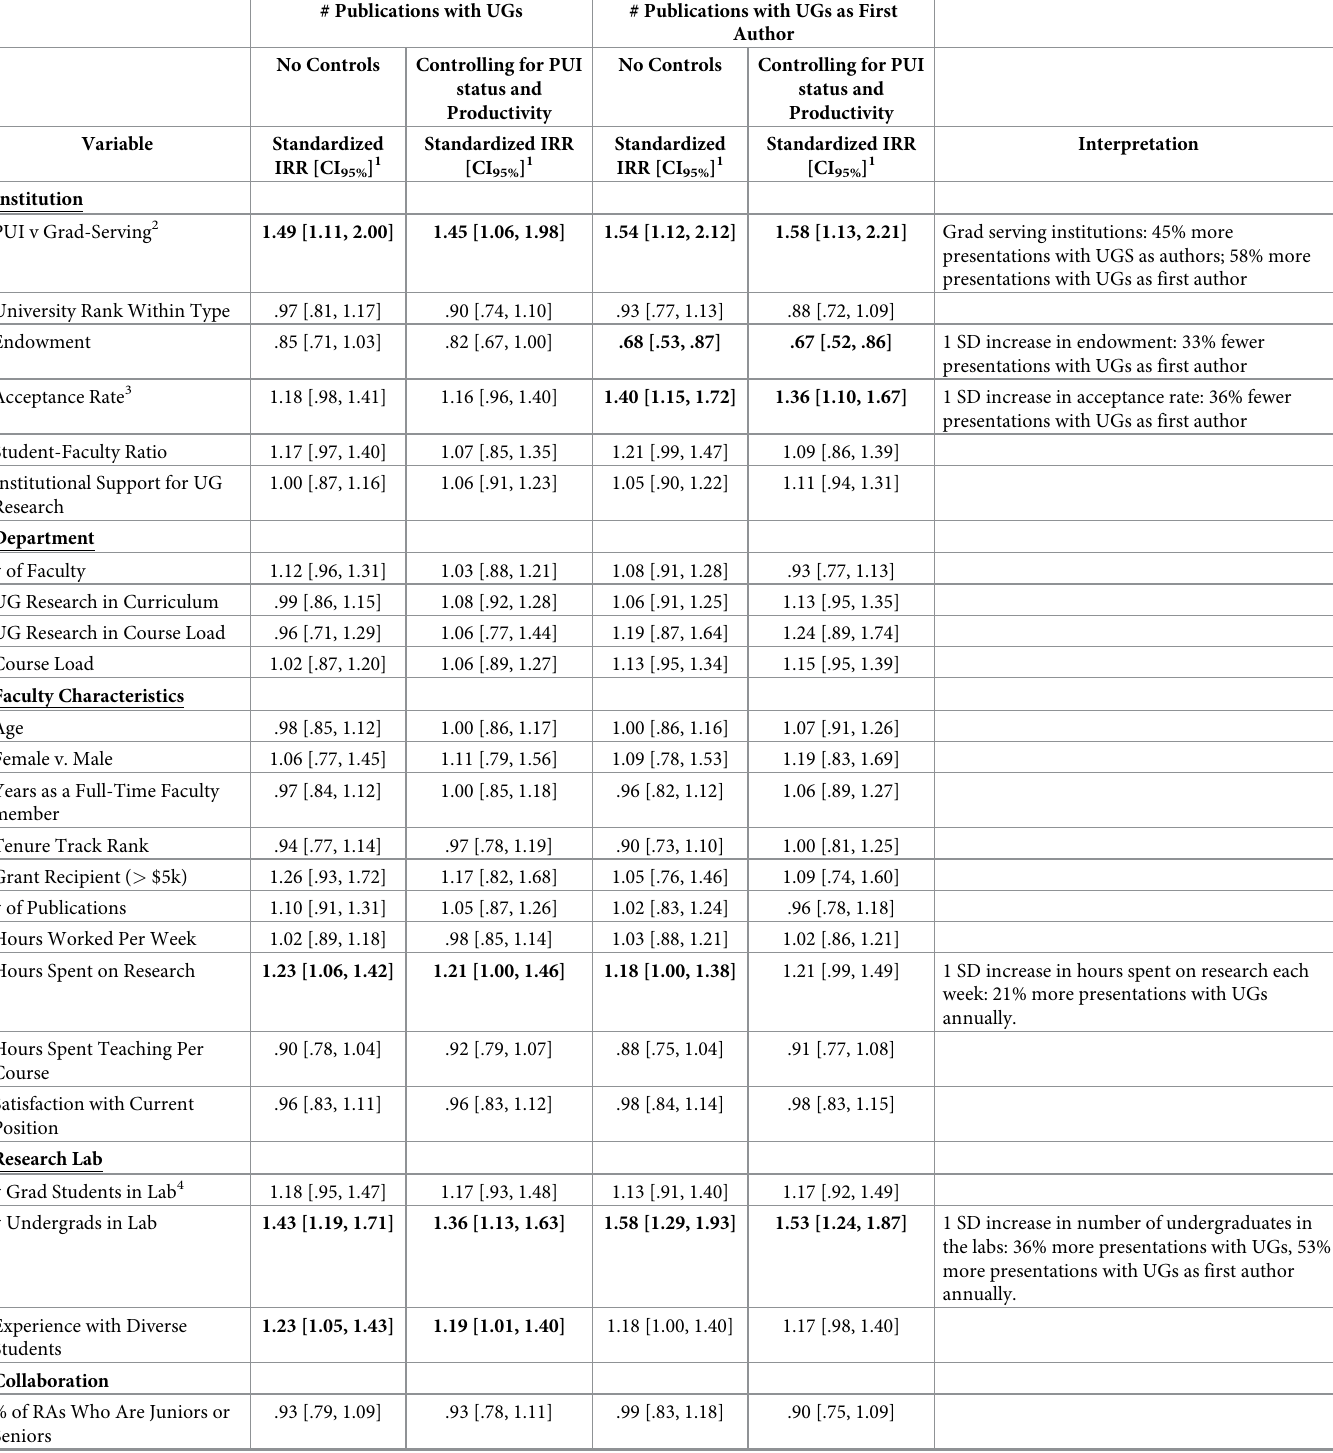
Table 4. Negative binomial regressions examining predictors of presentations with undergraduate (UG) authors (left estimates) and presentations with UG first authors (right estimates). # Publications with